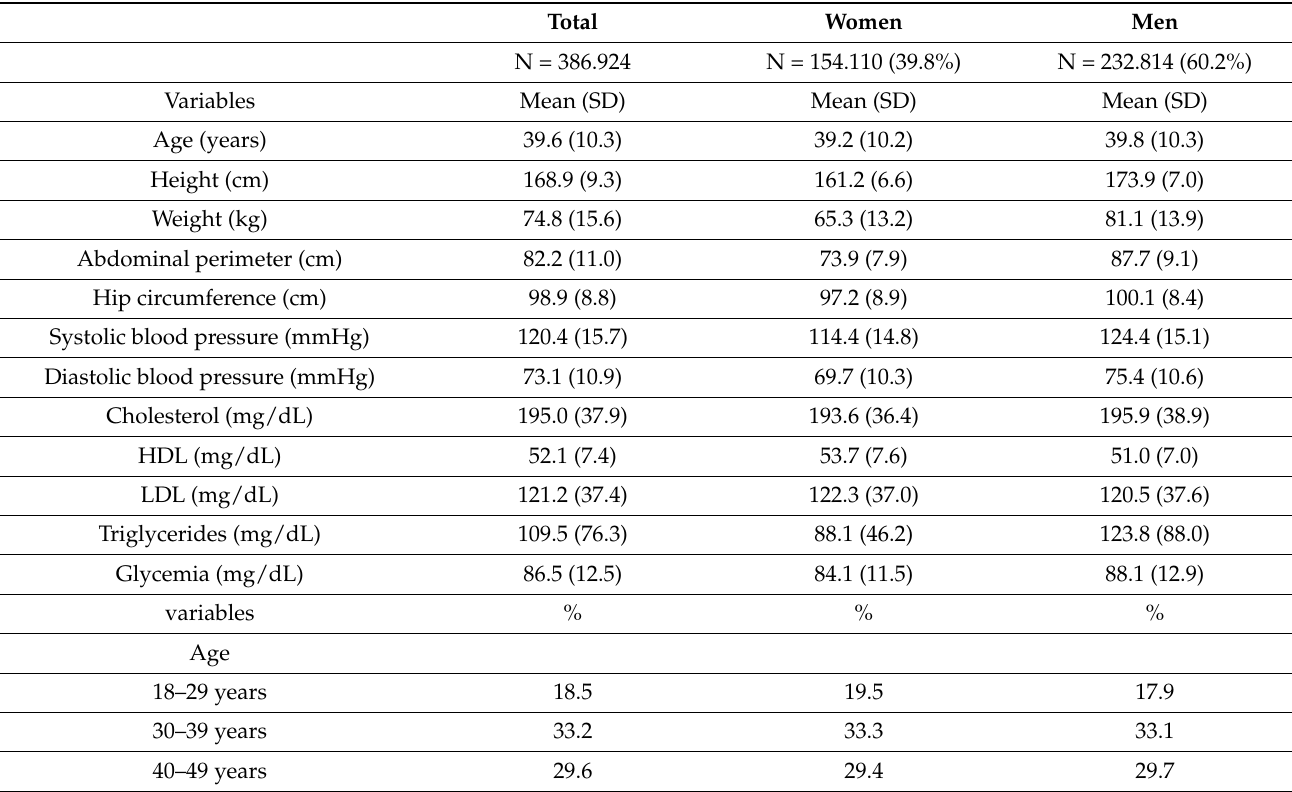
Table 2. Sociodemographic, anthropometric, clinical, and analytical characteristics of the sample.